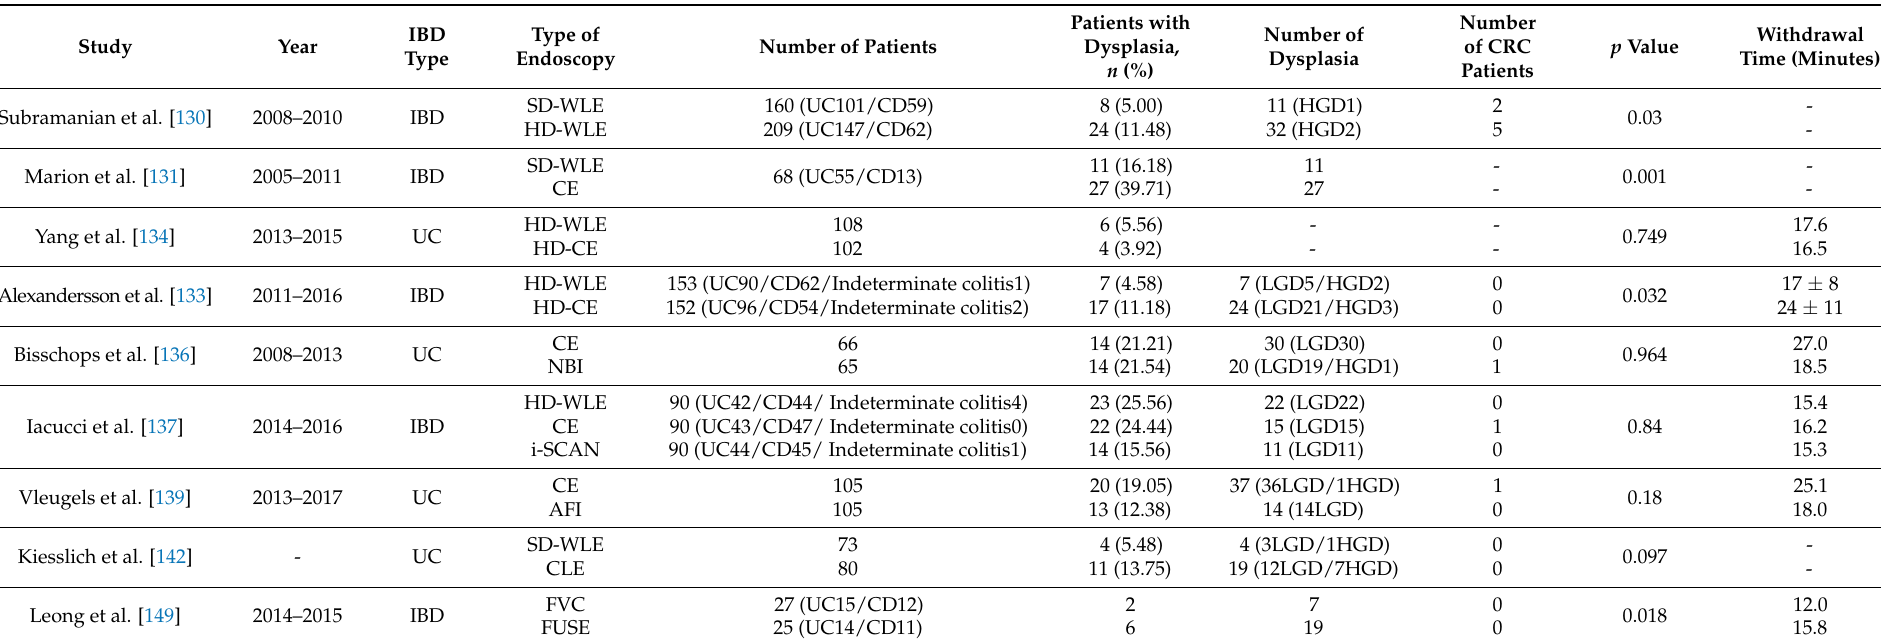
Table 1. A comparison of various surveillance modalities used for detecting colorectal dysplasia in patients with